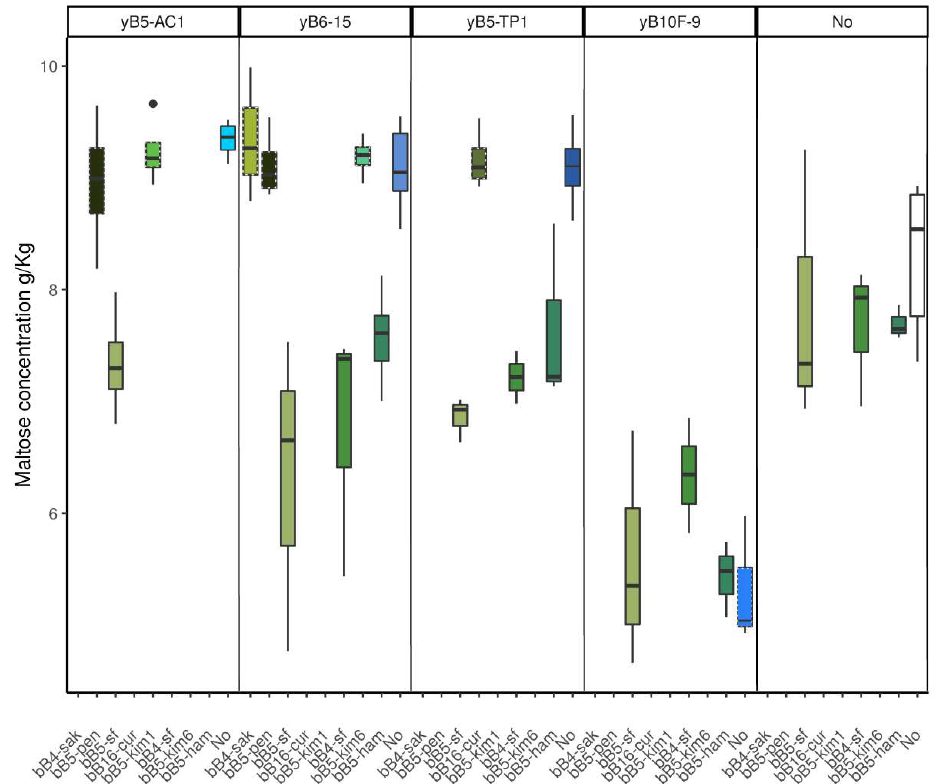
Figure 5. Maltose concentration after 6 h of fermentation. Each panel indicates fermentation for one of the tested yeast strains in coculture (green boxes) or monoculture (blue boxes). Obligately heterofermentative LAB strains are represented in plain lined boxes. S. cerevisiae is represented in dashed lined boxes while K. humilis in plain lined boxes. White boxes represent control dough without inoculum.